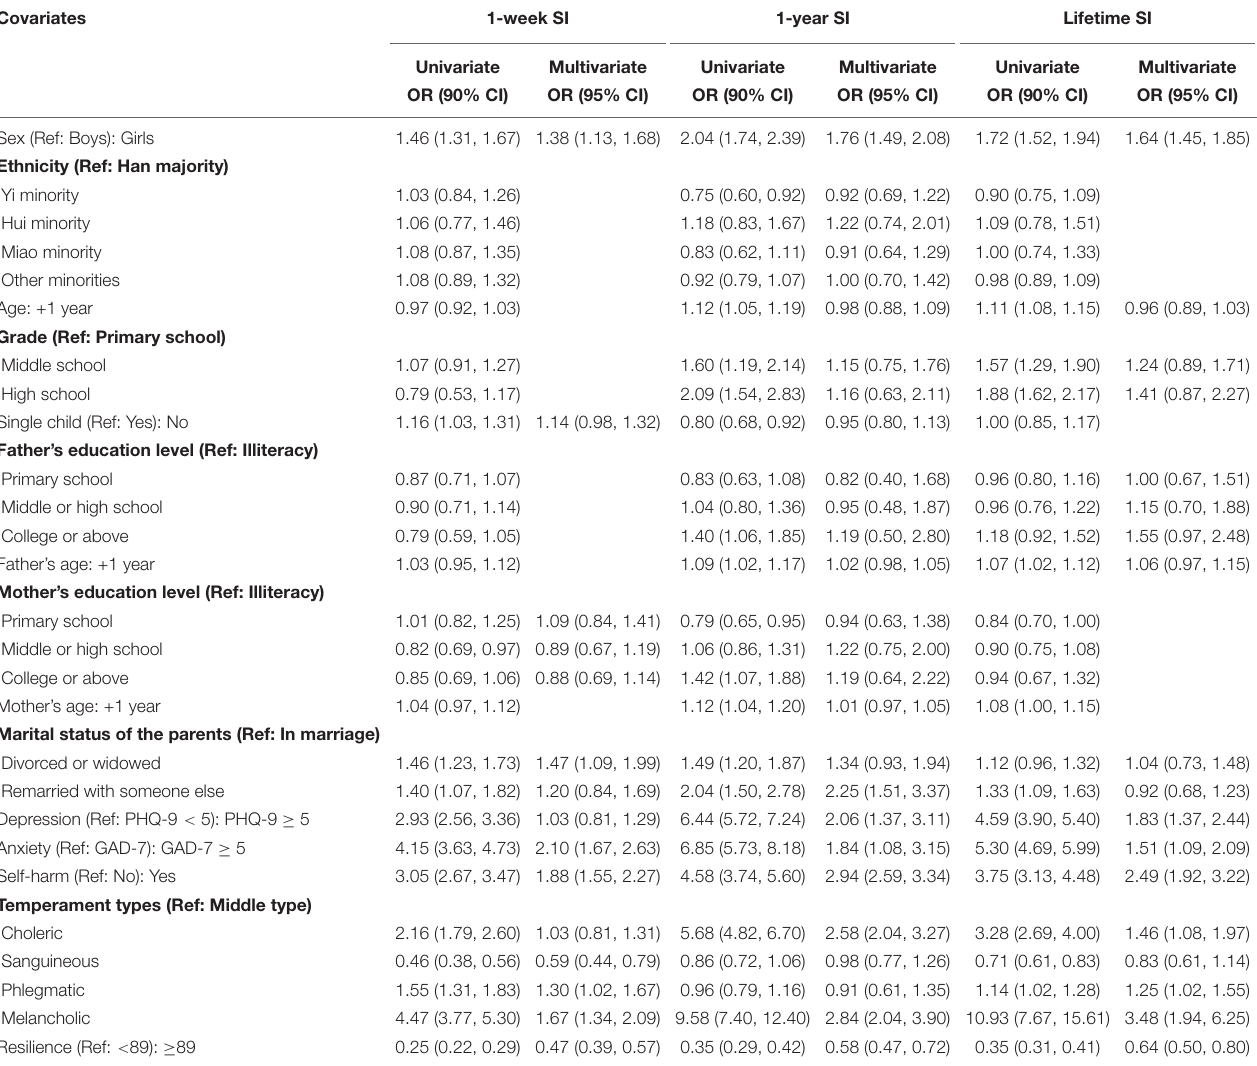
TABLE 2 | Univariate and multivariate logistic regression models fitting results for associated factors of different types of SI. Covariates 1-week SI 1-year SI Lifetime SI Univariate Multivariate Univariate Multivariate Univariate Multivariate OR (90%